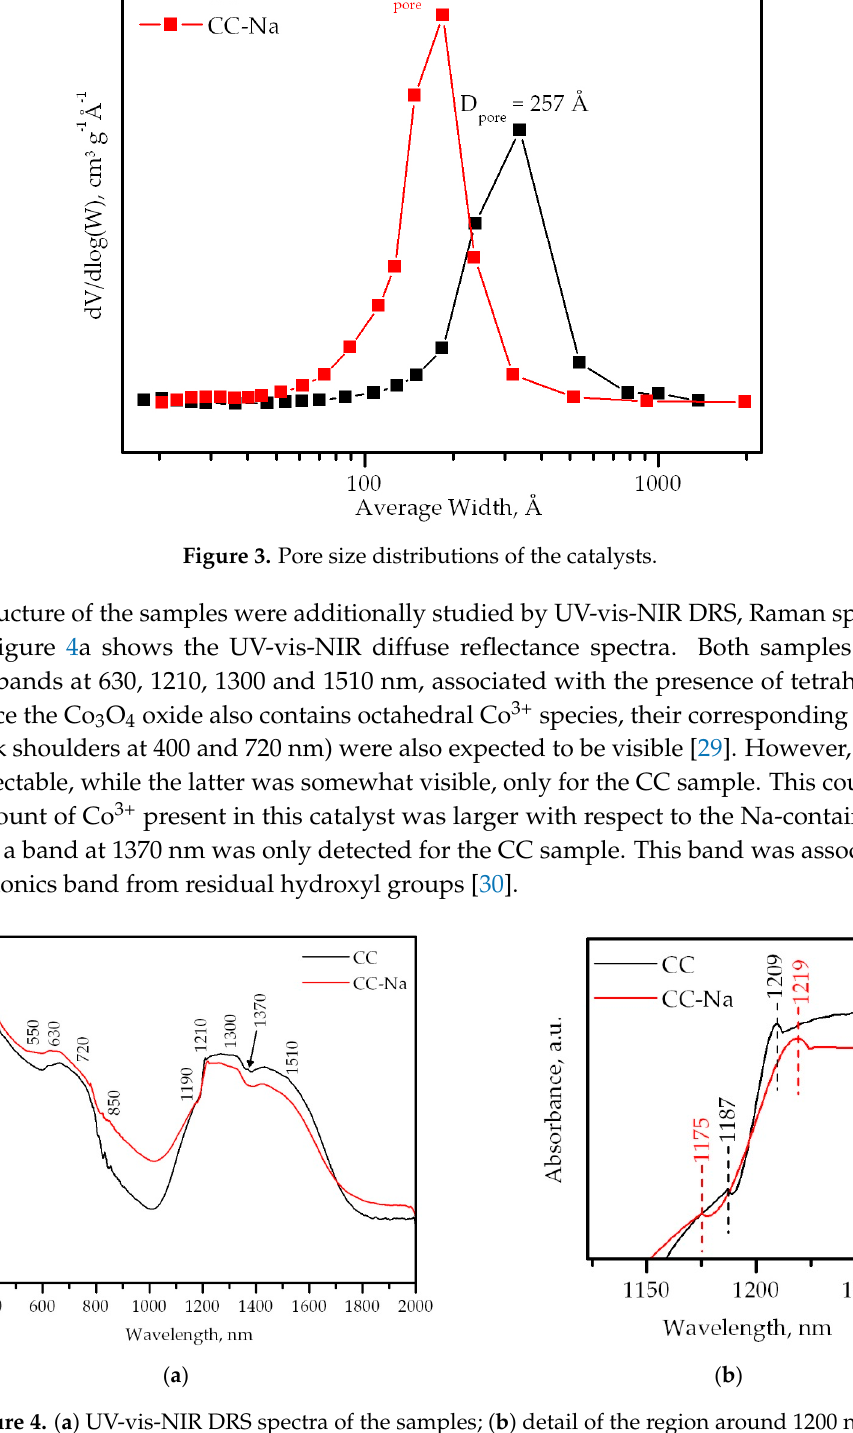
Table 1. Results from physico-chemical characterisation.